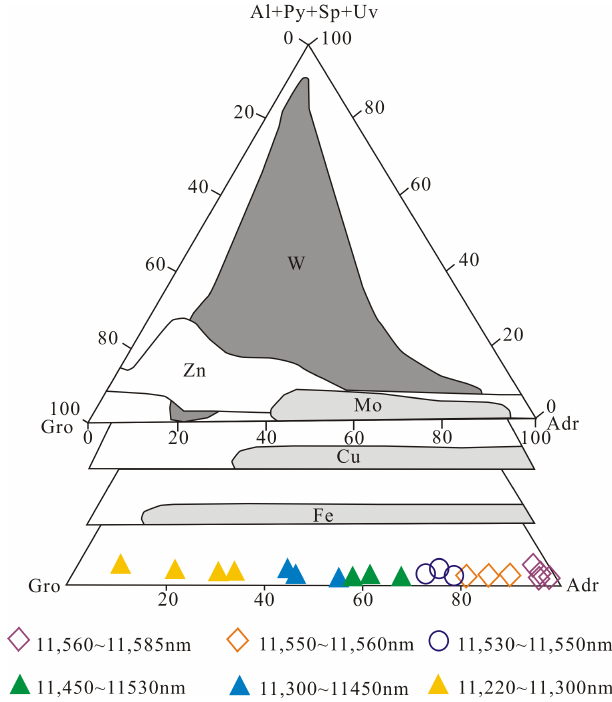
Figure 8. Triangular classification of garnet in the Jiama deposit (the base map according to [2]. Abbreviations: Adr = andradite; Gro = grossular; Al =almandine; Py = pyrope; Sp = spessartine; Uv = uvarovite).